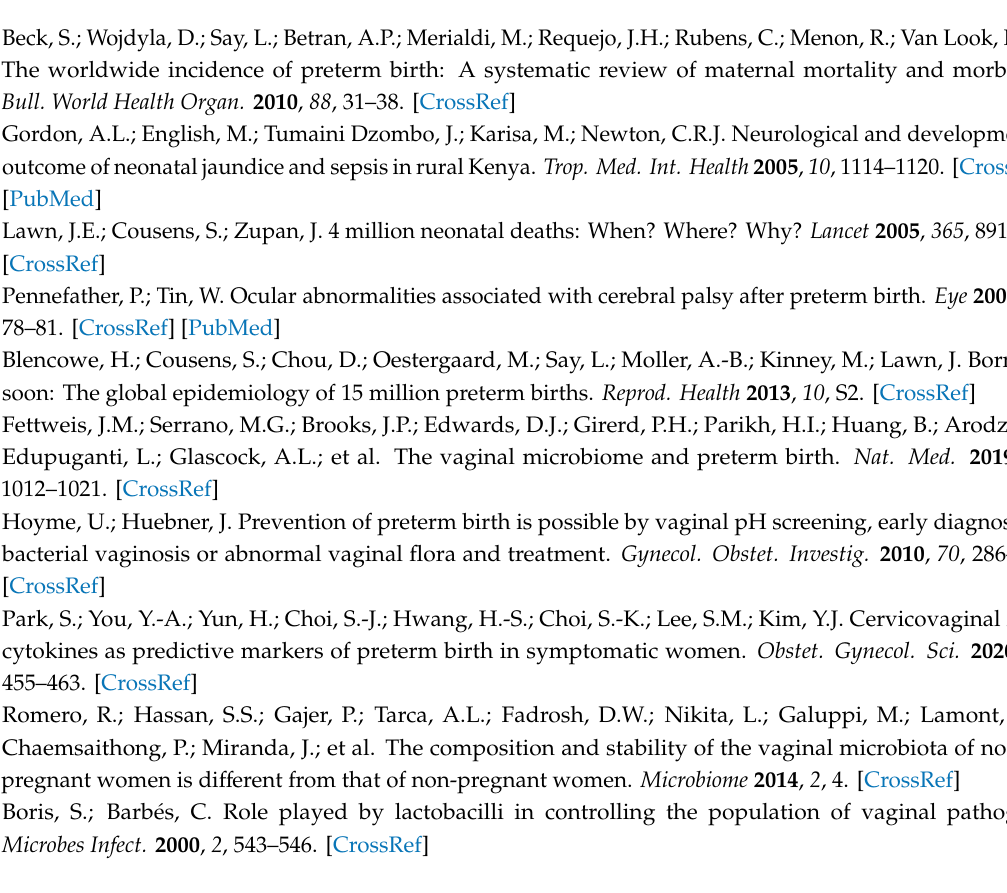
Figure S1: Representative 800 MHz 1 H-NMR spectrum obtained from the CVF sample, Figure S2: Principal component analysis, Table S1: 1 H chemical shift and relative concentrations of the identified metabolites in CVF from PTB and TB, Table S2: The false discovery rate (FDR) of metabolites, Table S3: Predictive performance for the combined model of metabolites and